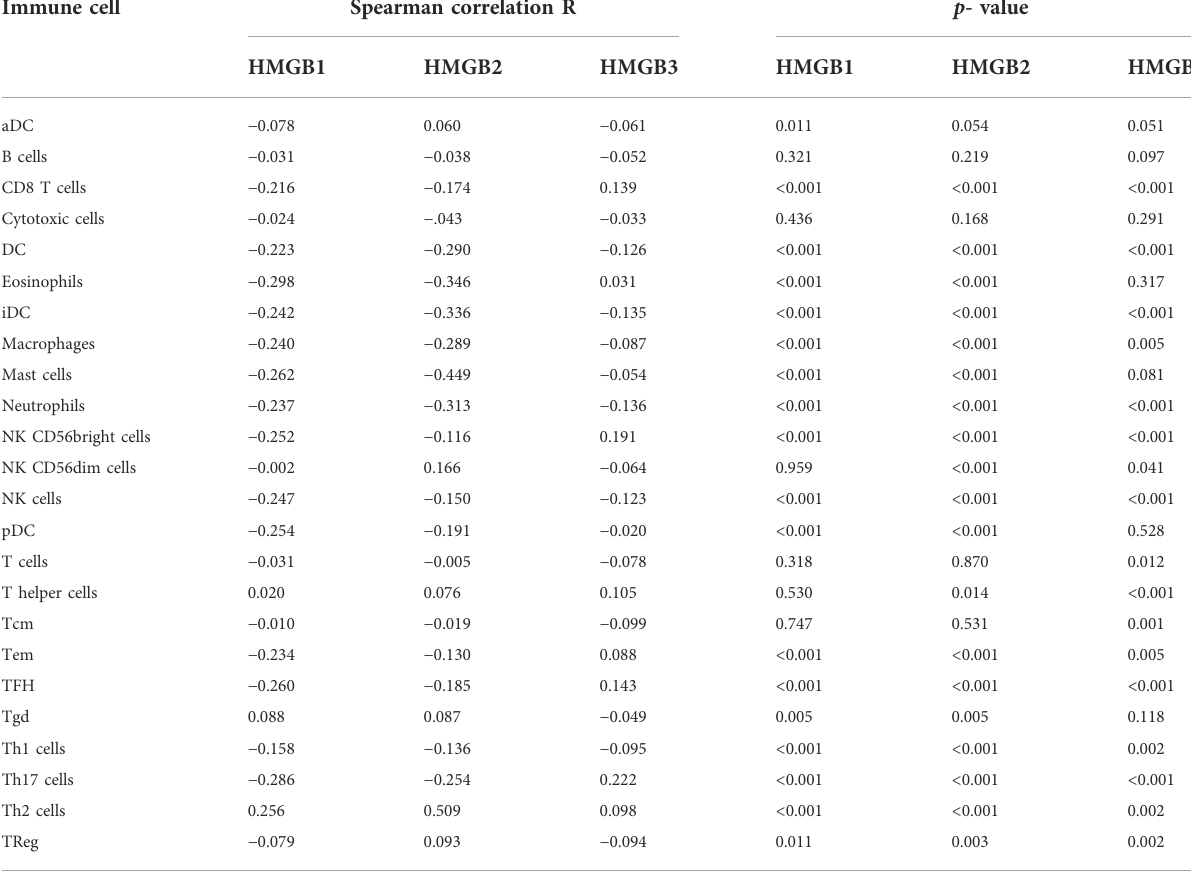
TABLE 4 The Spearman correlation R value and p -value of HMGB family members with in fi ltrating immune cells in NSCLC samples. Immune cell Spearman correlation